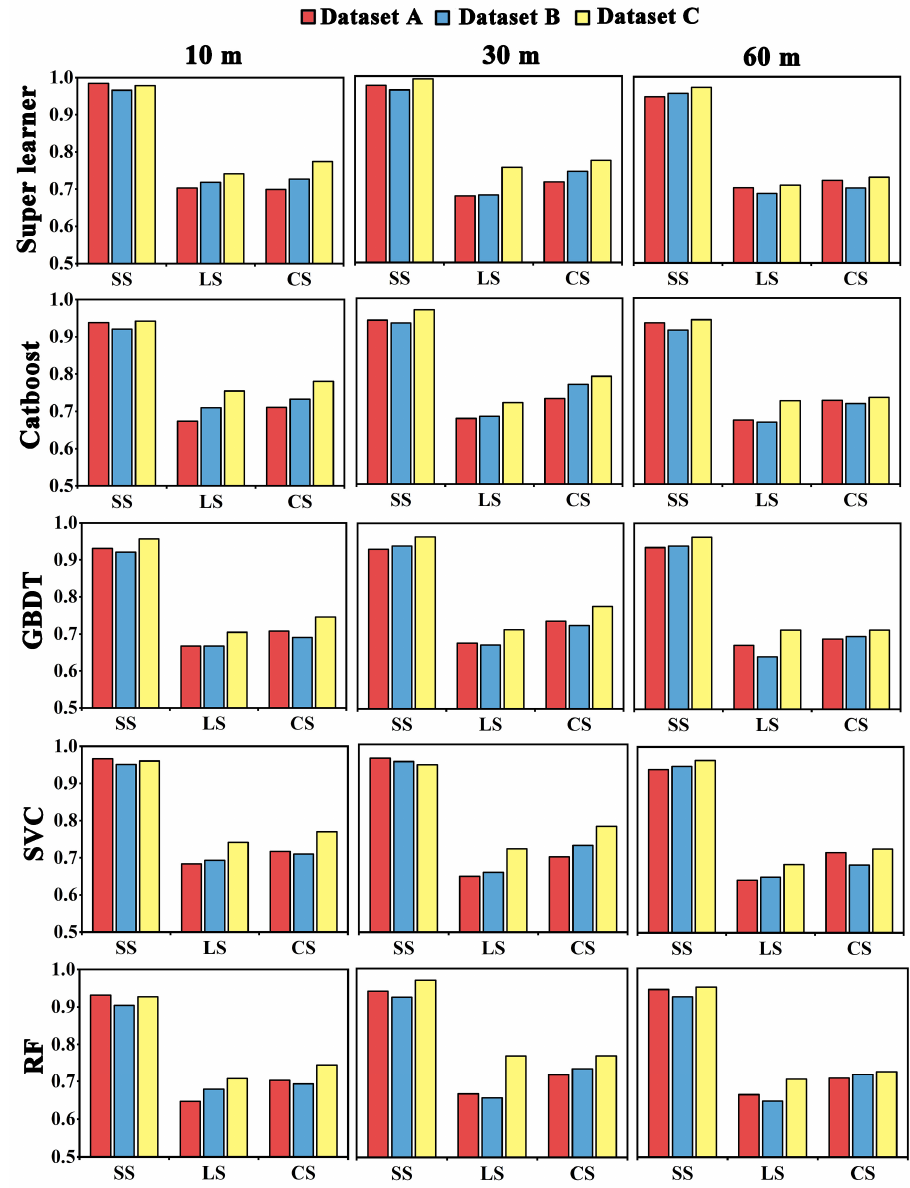
Figure 7. The accuracy (F1-score) histogram for identification of different soil textural classes at three modeling resolutions using five methods (SS: sandy soils; LS: loamy soils; CS: clayey soils. Dataset A: purely remote sensing variables from Landsat-8 data. Dataset B: purely remote sensing variables from Sentinel-2 data without red-edge factors. Dataset C: purely remote sensing variables from Sentinel-2 data with red-edge factors).